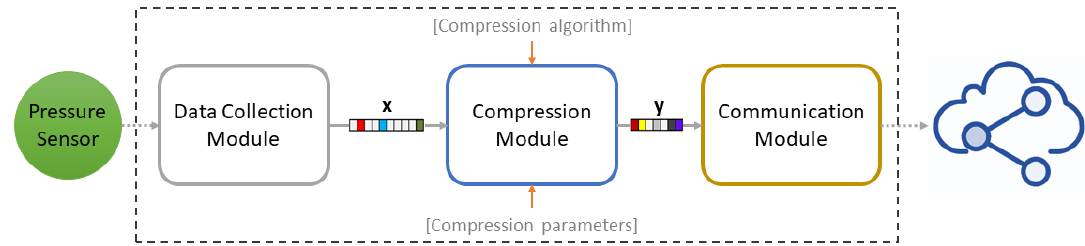
Figure 8. Edge device software